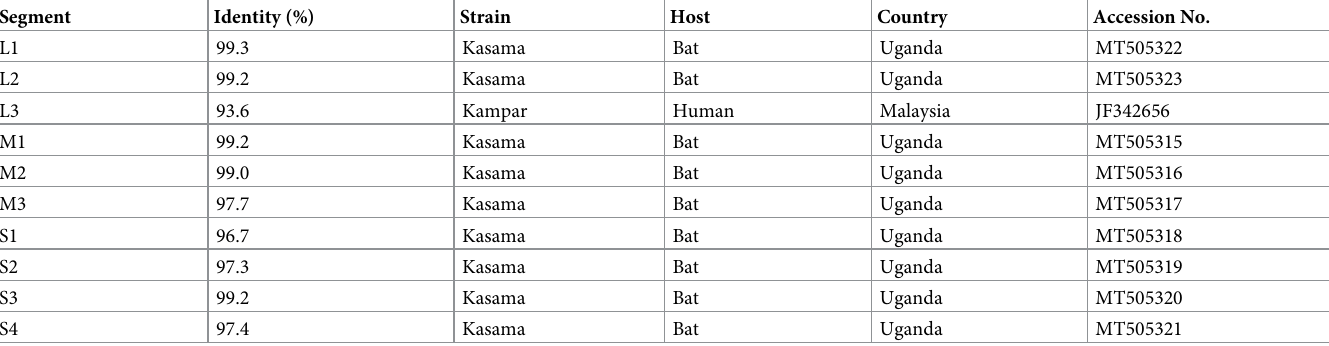
Table 3. BLAST analysis based on nucleotide sequences of each segment of Nachunsulwe-57. Segment Identity